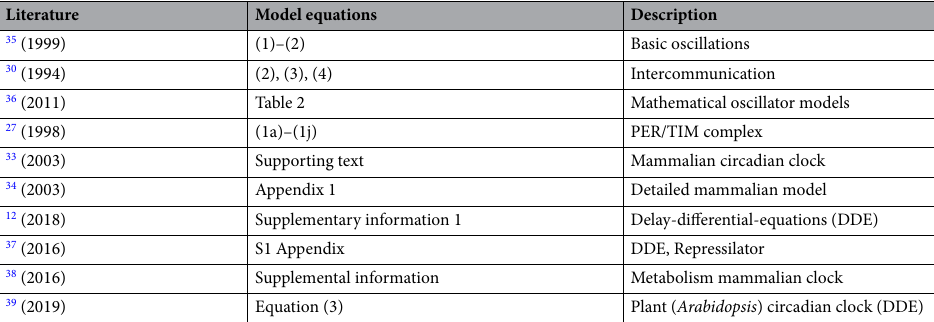
Table 2. In this table there is a selection of model equations that can be chosen for the combination with our external stimuli framework instead of the Goldbeter model used in this work by substituting the model equations in the provided Mathematica files with the equations referenced in the column “Model equations”. In the column “Literature” there is the reference of the publication with the year of publication and in the column “Description” we give a keyword describing the presented